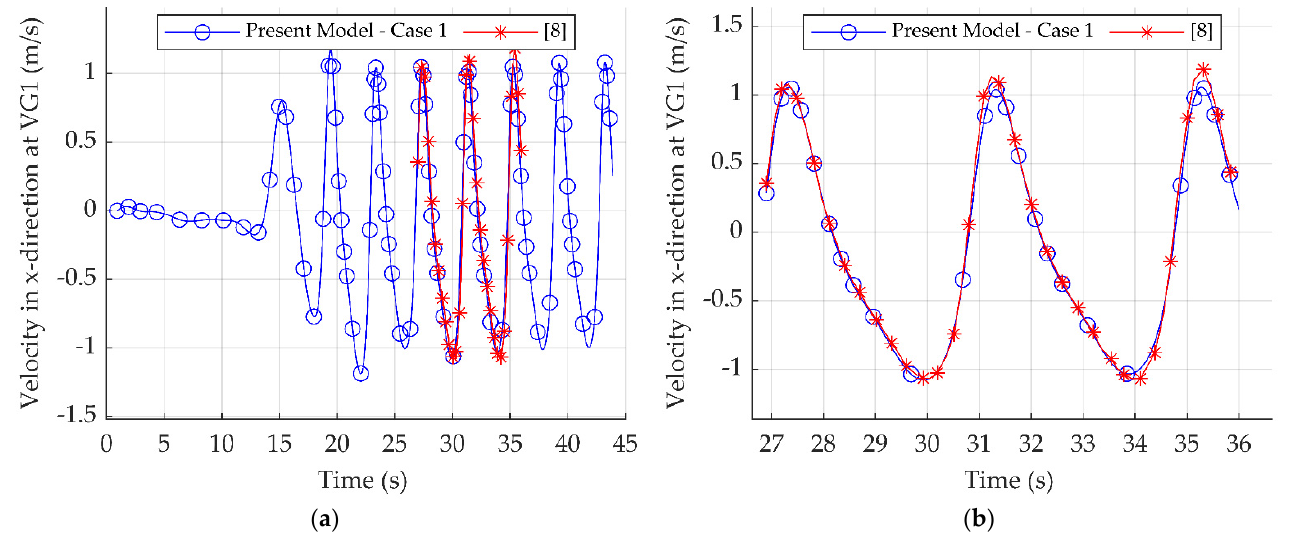
Figure 7. Comparison of the velocity in the x- direction at VG1 and the results of [8] for: ( a ) the entire simulation time, ( b ) the numerical results simulation time. Table 10. Comparison of the velocity in the x- direction at VG1 and the results of [8]. Wave Gauge